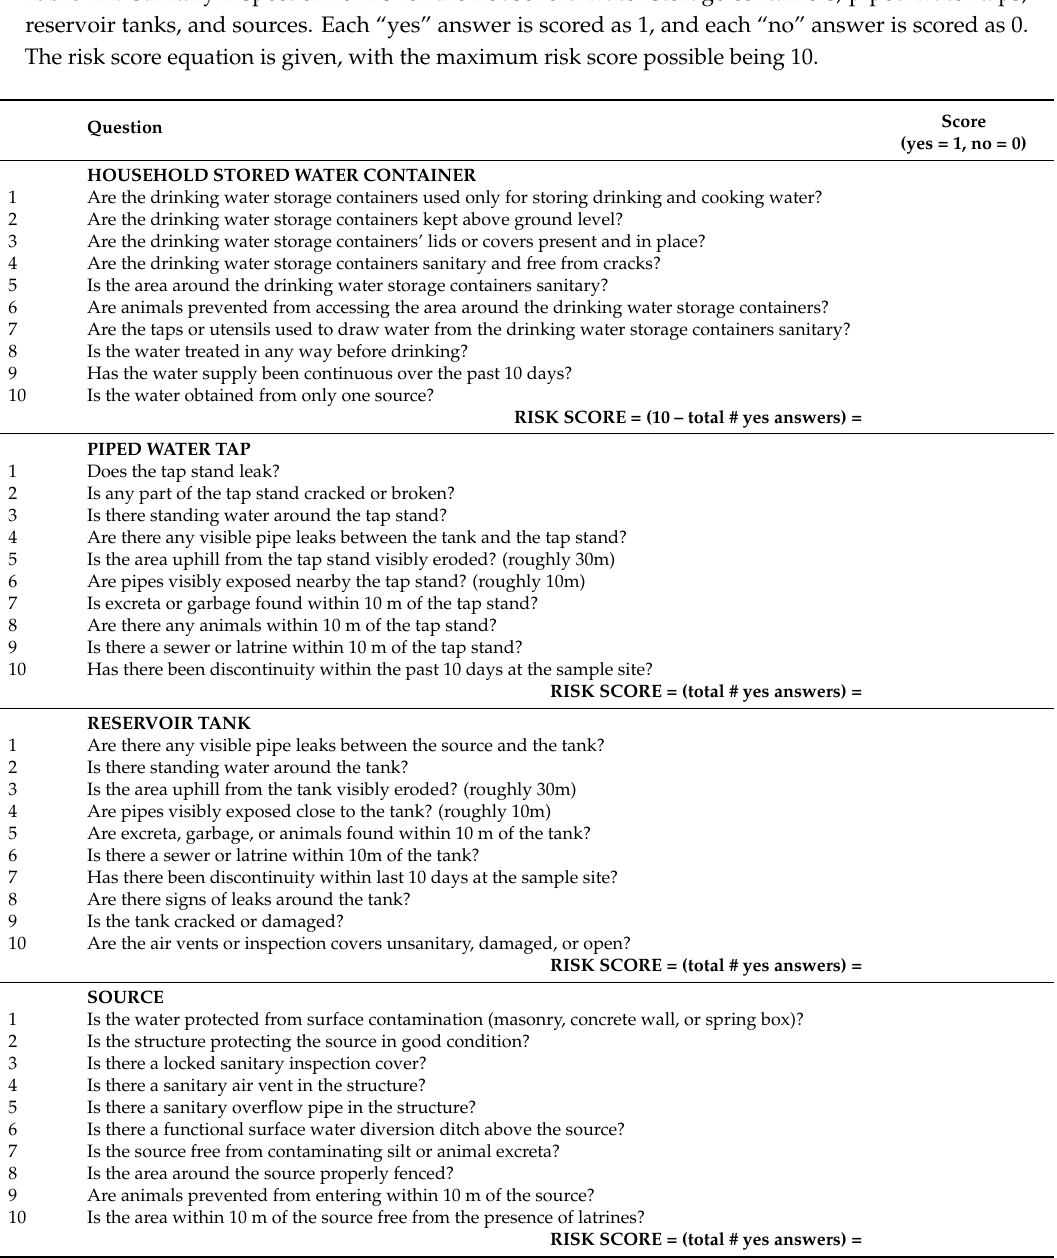
Table A1. Sanitary inspection forms for the household water storage containers, piped water taps, reservoir tanks, and sources. Each “yes” answer is scored as 1, and each “no” answer is scored as 0. The risk score equation is given, with the maximum risk score possible being